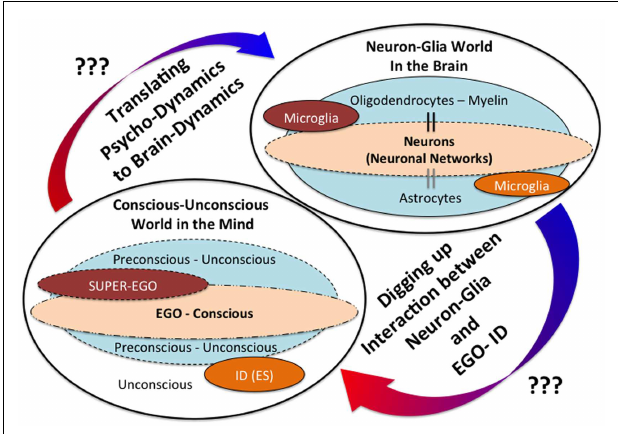
FIGURE 1 |The mind-brain gap from a novel glial neuropsychoanalytic perspective .The interaction between the mind and the brain has not been well understood. Freud, the founder of psychoanalysis, proposed the conception of mind structure models consisting of the following three components: the ID (unconscious/instinctual drives), the EGO (the exclusive apparatus of the conscious mind), and the SUPER-EGO (which represses the id in order to avoid any disruptions of rational thought).The existence and the significances of these mental components may be explained by future understandings of the neuron-glia interactions.The hypothetical interaction between the ID (unconscious drives) and microglia has already been proposed in our recent theoretical paper